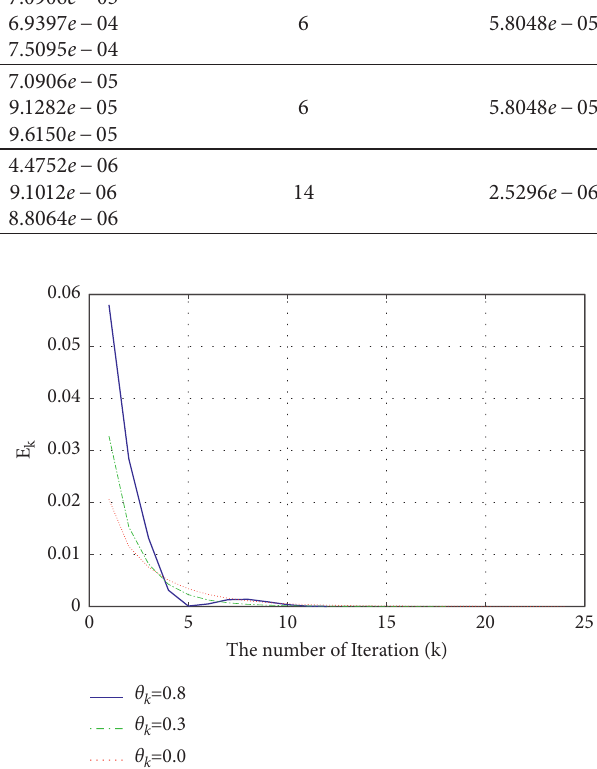
Figure 1: Error against iterations for Algorithm 1 with difference choices of θ k , under ρ k � 3 . 98 and ε � 10 − 5